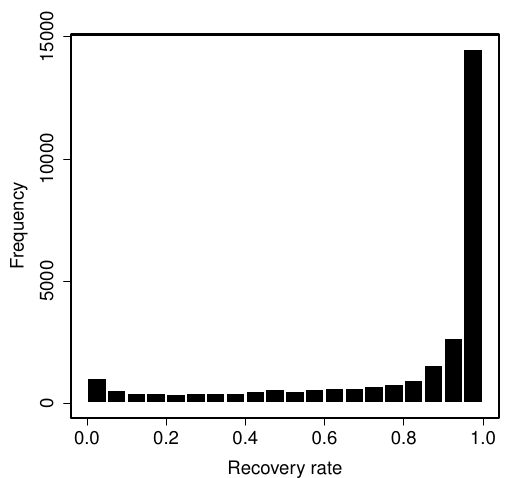
Figure 3. Frequencies of recovery